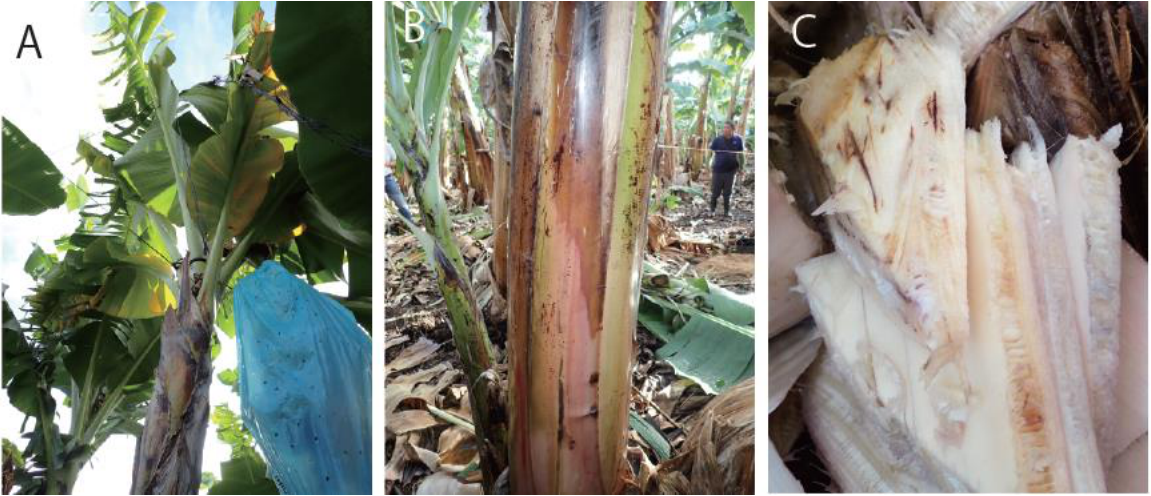
Figure 1. Infection symptoms of bananas (cv. Cavendish). ( A ) yellowish leaves; ( B ) brownish pseu- dostem; ( C ) brownish xylem. pseudostem; ( C ) brownish